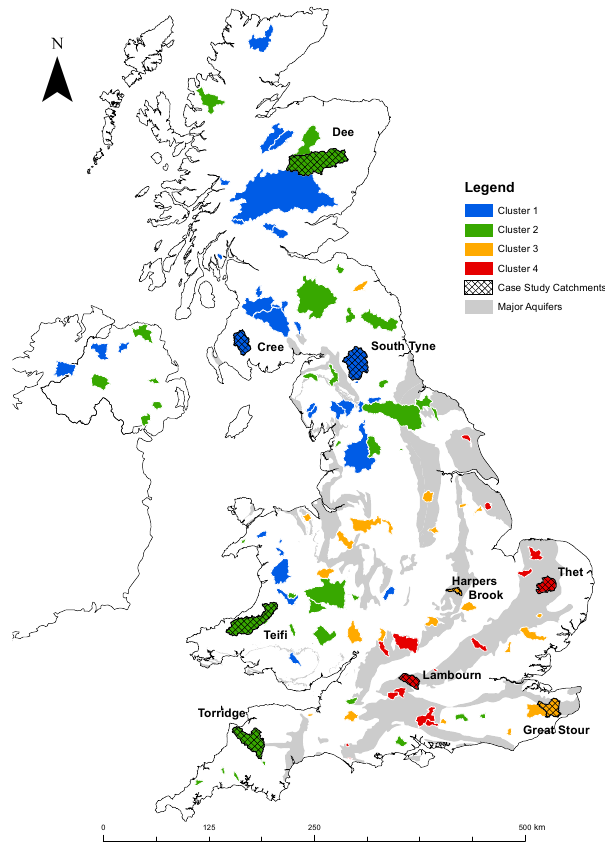
Figure 1. Location and cluster membership of UK Benchmark catchments selected for this study, including the nine case study